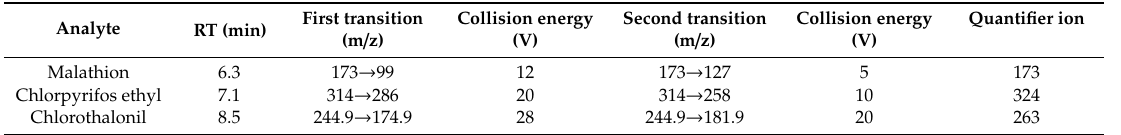
Optimized ultra performance liquid chromatography-tandem mass spectrometer (UPLC-MS / MS) parameters for the selected pesticides on prickly pear pad crop.